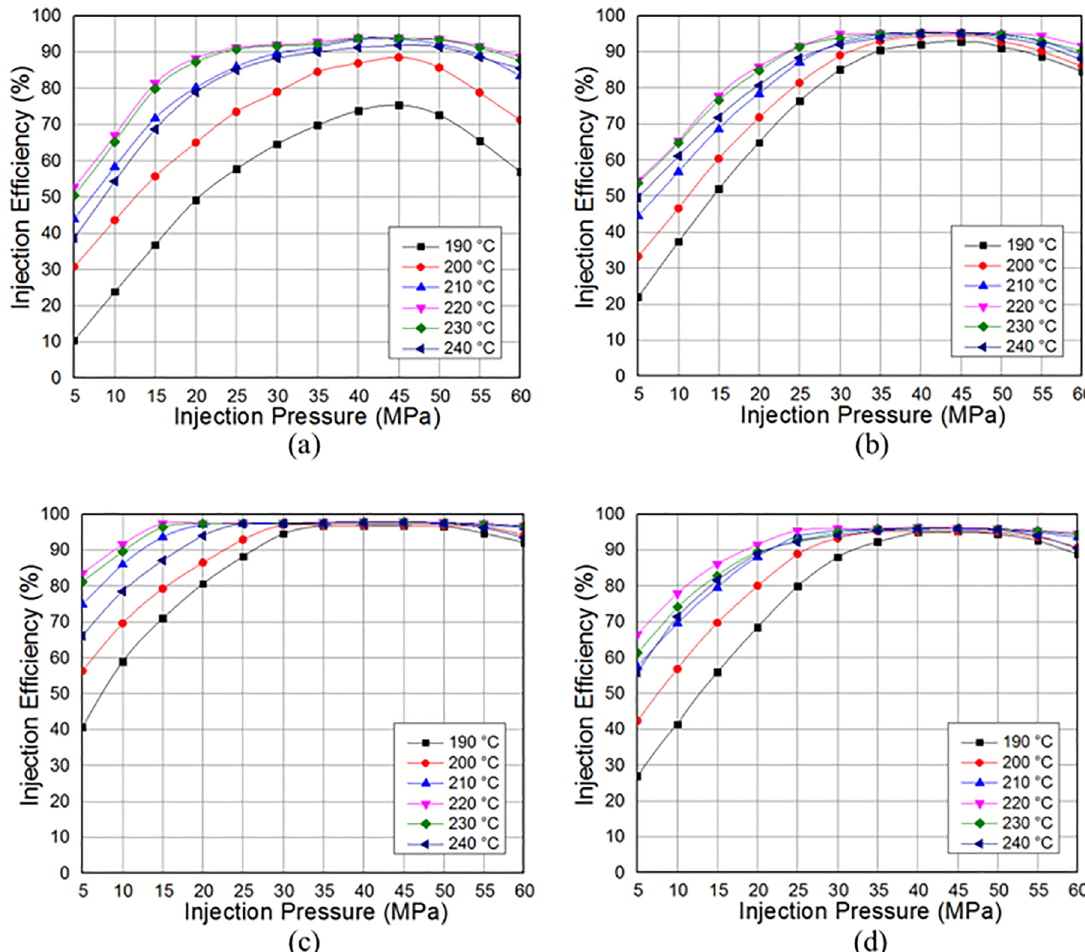
Figure 6. Injection efficiencies obtained with the original mold (no venting system) by varying the injection pressure and temperature for distinct situations of mold temperatures: a) 20 ºC; b) 30 ºC; c) 40 ºC; d) 50